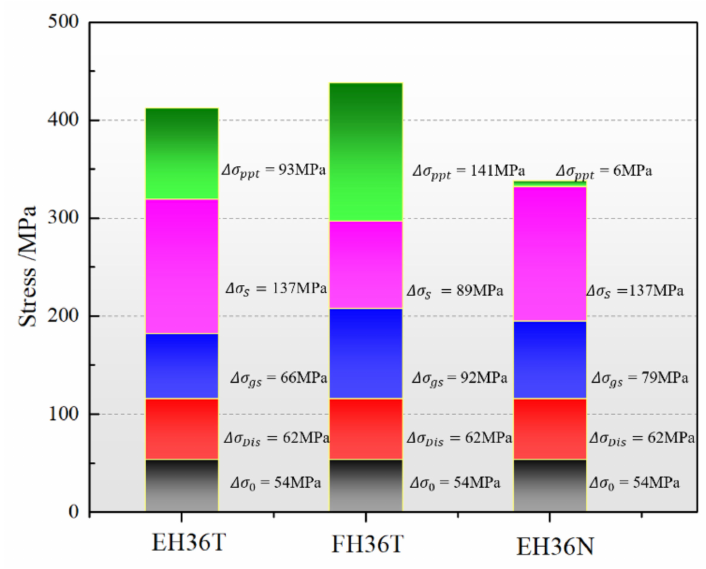
Figure 9. Contribution to the yield stress of the different strengthening